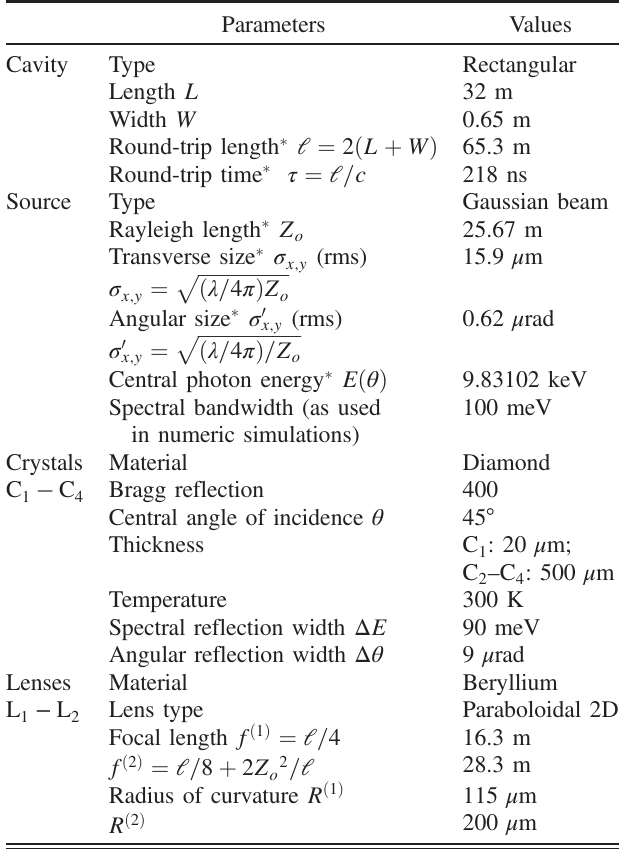
TABLE I. Parameters of the rectangular cavity, x-ray source, and optical components [23] used in the calculations presented in the paper. Parameters marked with asterisk are derived from other parameters of the